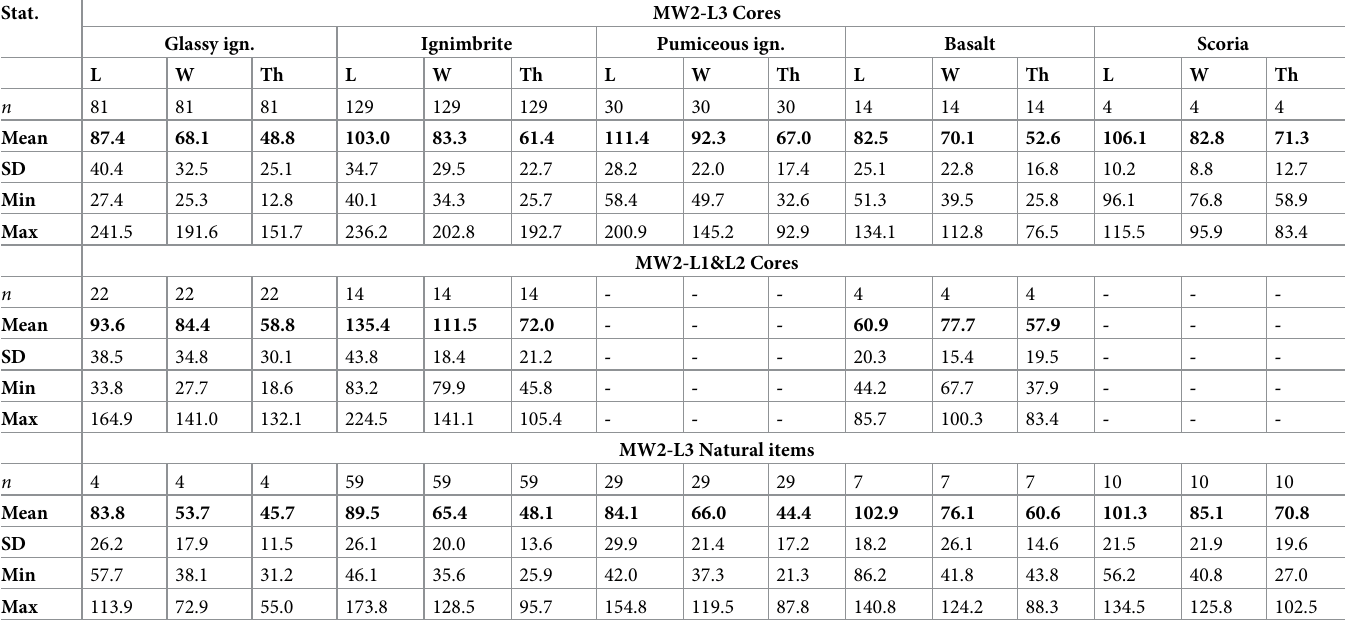
Table 4. Descriptive statistics (means in bold) of dimensions of cores and natural items (per raw materials) in MW2 assemblages. Stat. Glassy